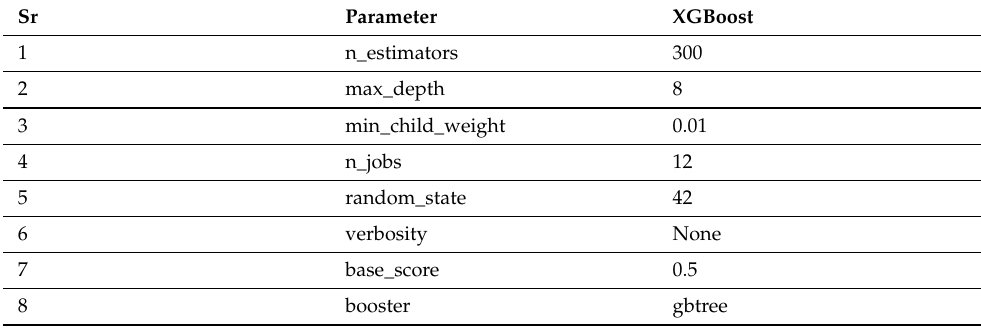
Table 3. Parameters values utilized in the experimental model.